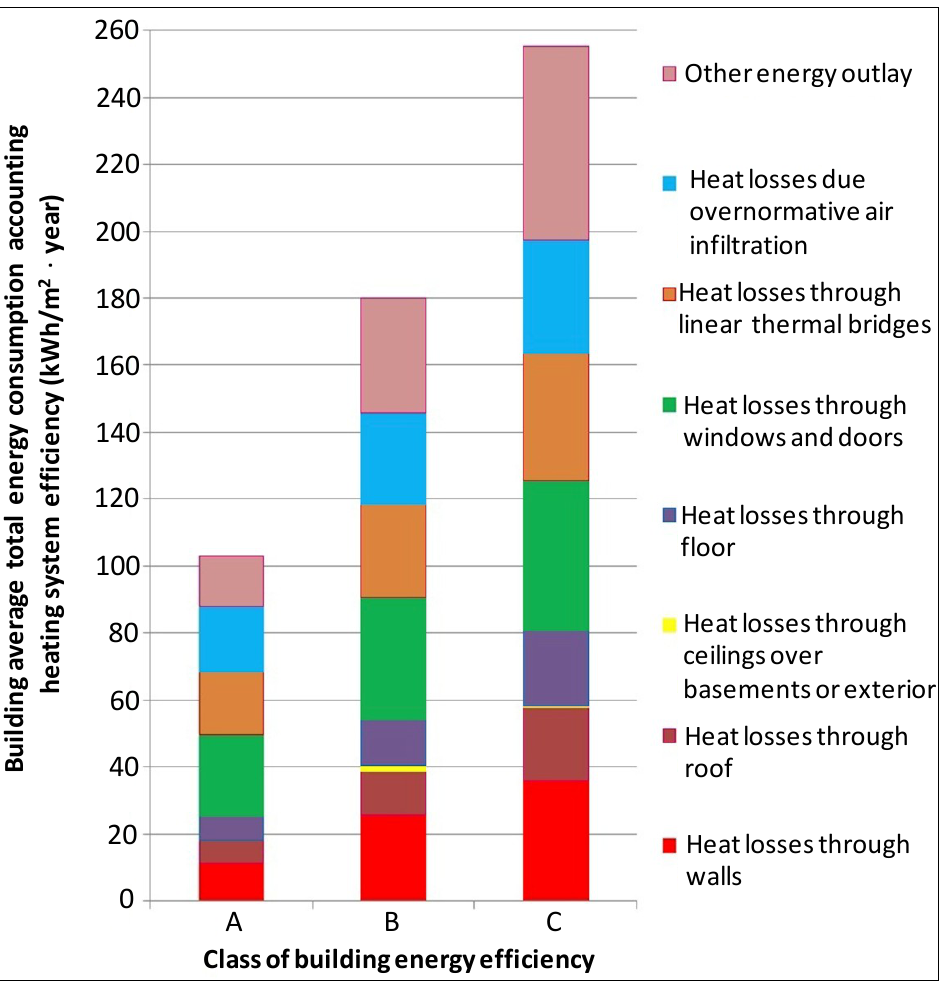
Figure 1. Sum energy consumption of the building according to the energy efficiency